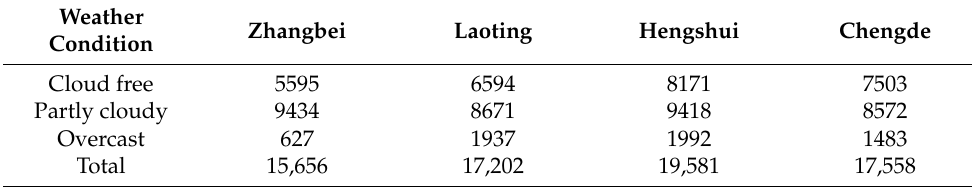
Table 1. The amount of data for different weather types at the four observation